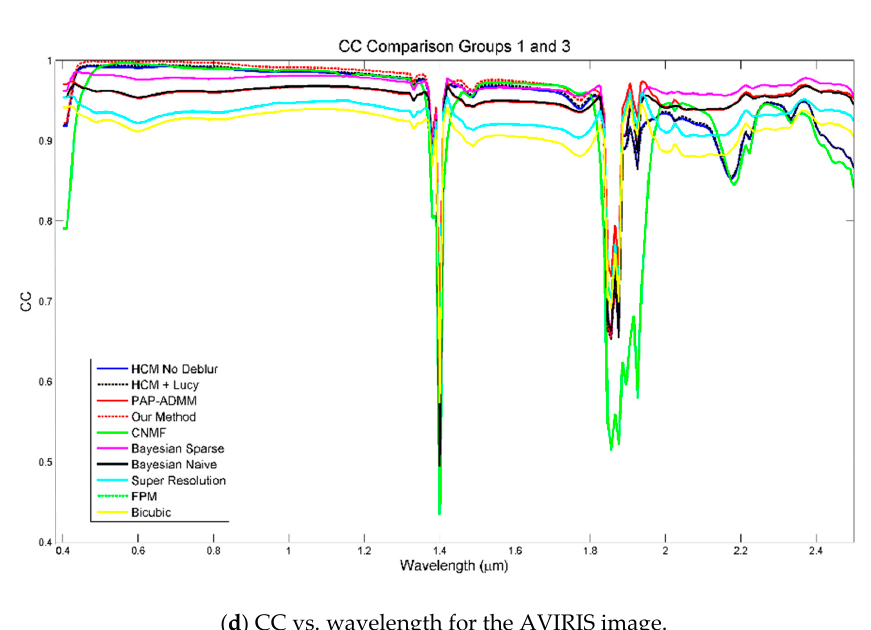
Figure 6. Comparison of RMSE and CC between our method and methods in Groups 1 and 3.